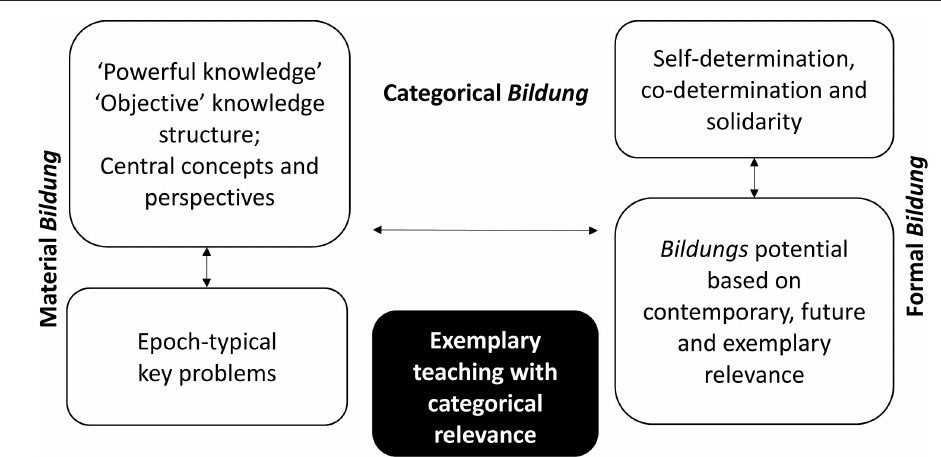
Figure 1: Principal conceptual map for the selection of content for teaching social issues: curriculum